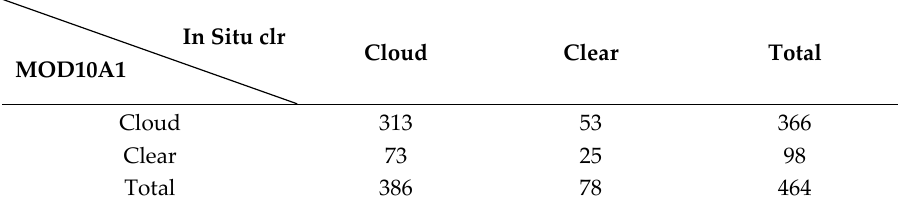
Table 4. Contingency table of MOD10A1 cloud mask versus in-situ cloud index for clr = 0.7.